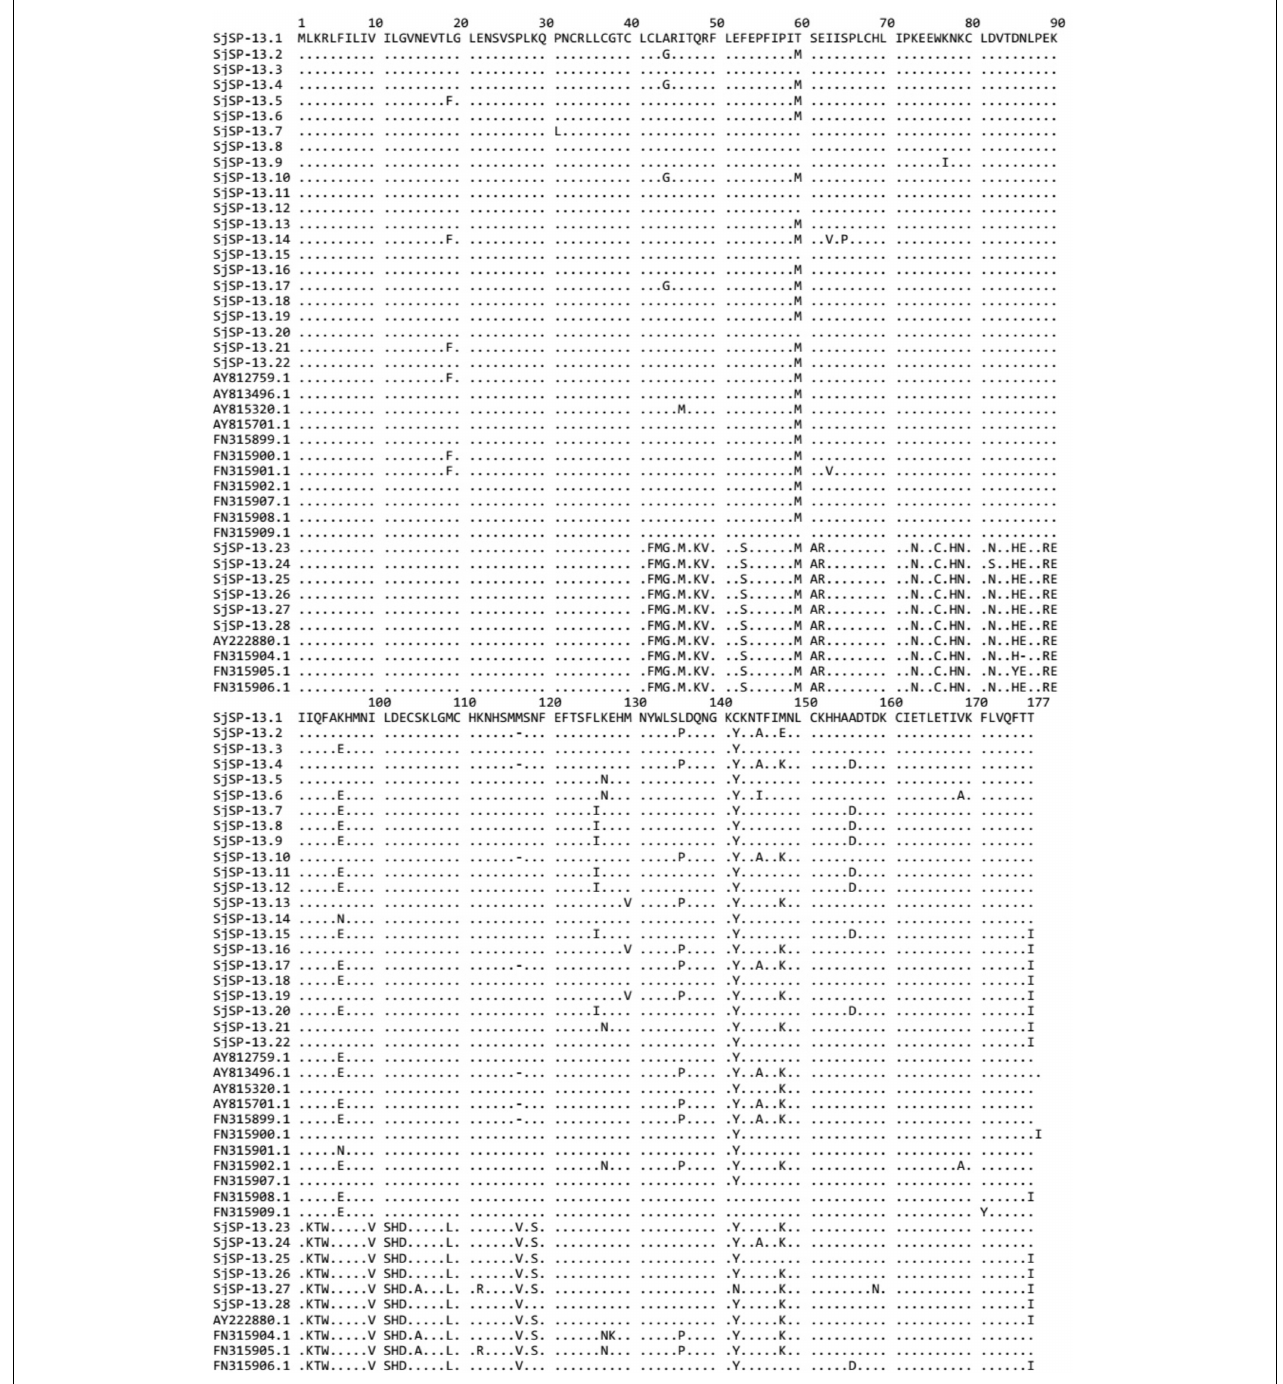
FIGURE 2 | Alignment of amino acid sequences of SjSP-13 alleles. Numbers indicate the position of amino acid residues. Dots indicate the same amino acid residue as that present in SjSP-13.1.